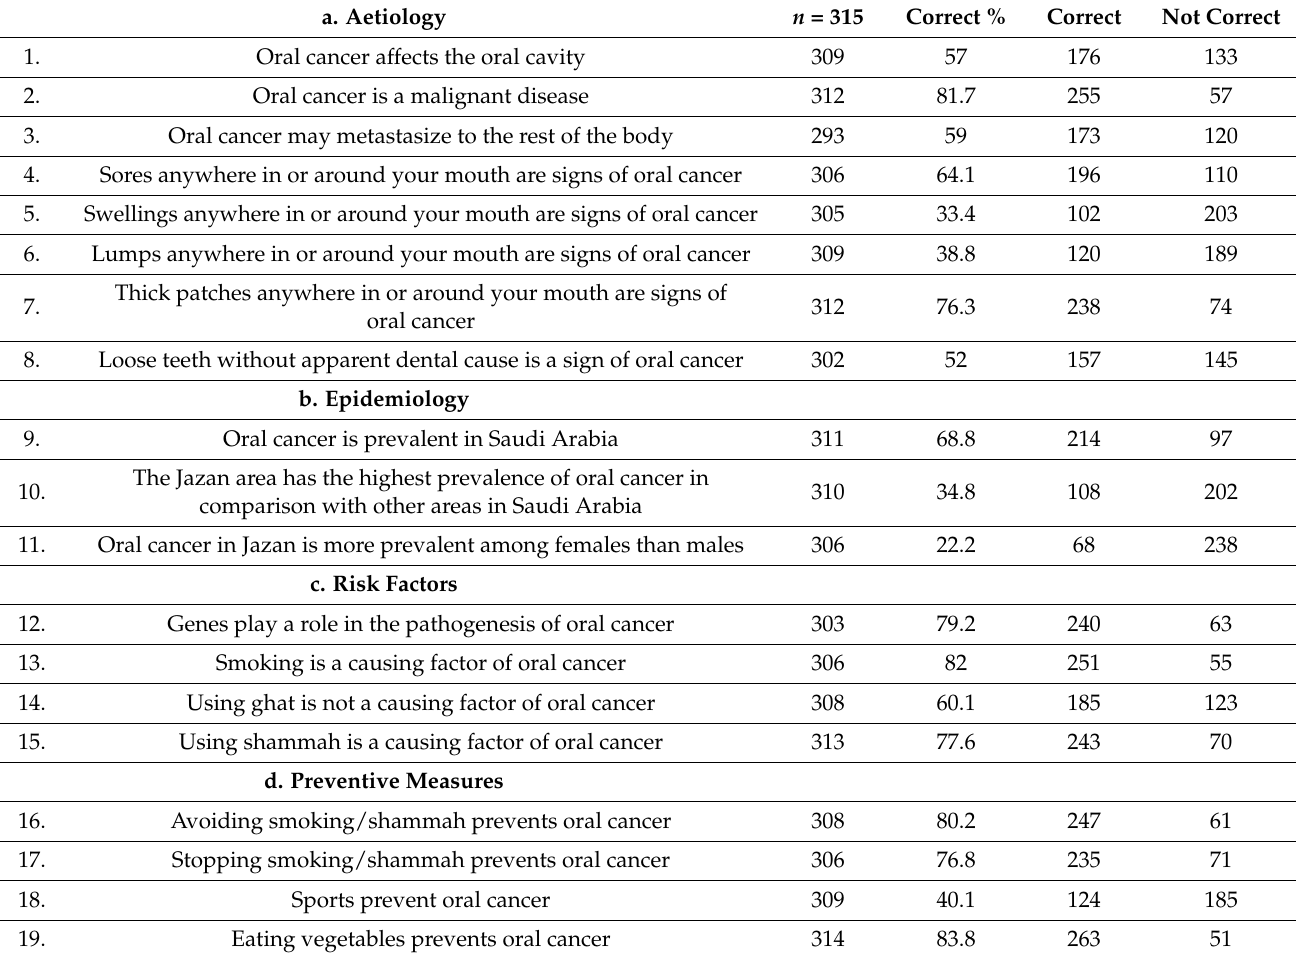
Table 2. Dental patients’ knowledge toward oral